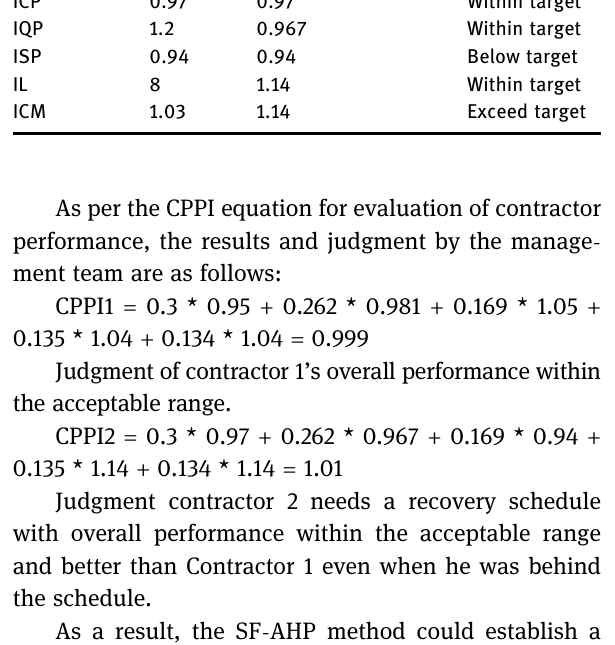
Table 12: Contractor 2 normalized calculations for indicators Indicator